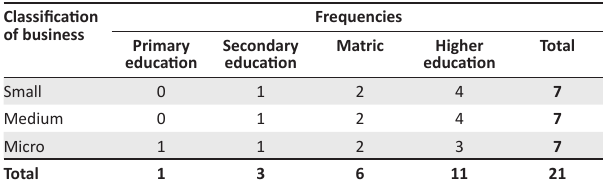
TABLE 4: Level of education.